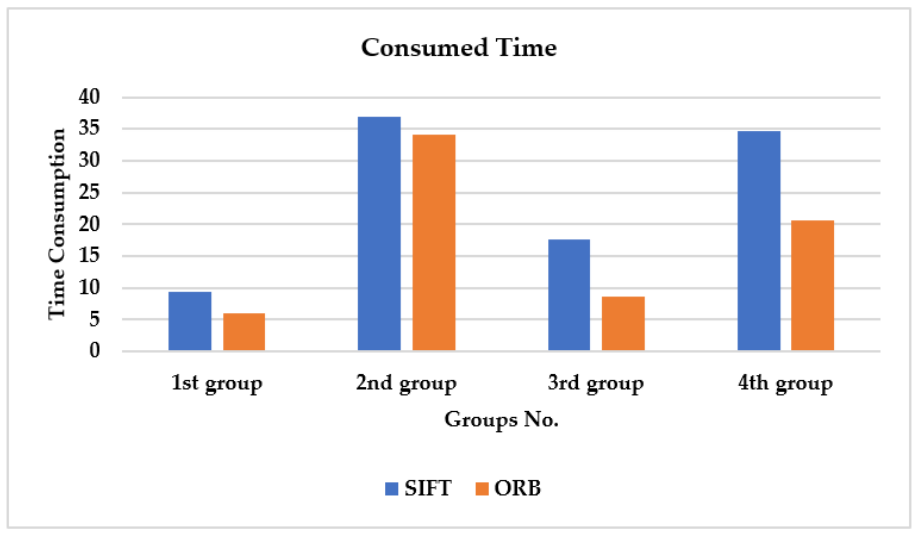
Figure 22. Time consumed for feature extraction over the four groups created from TU Berlin dataset using methods based on handcrafted features.